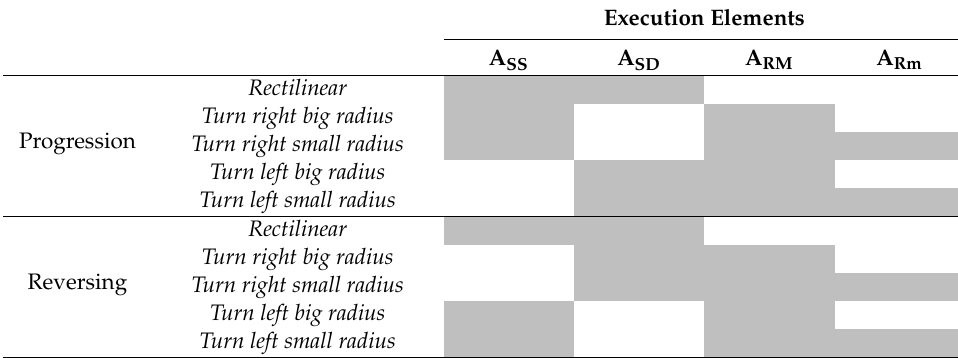
Table 1. Graph representing the evolution for turn commands.